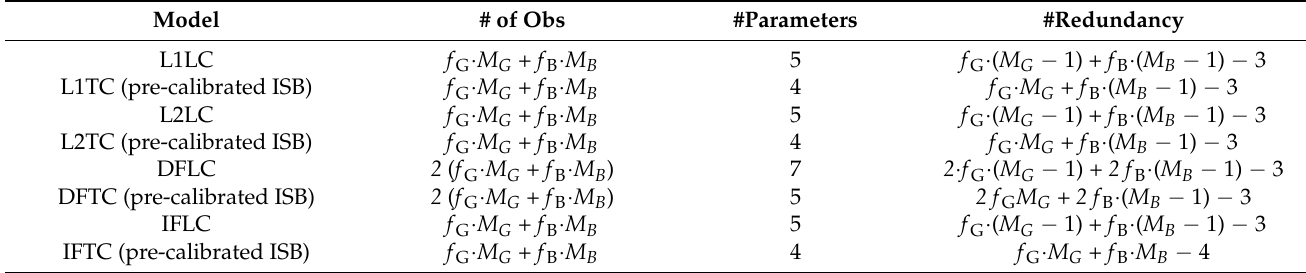
Table 1. Redundancy of different